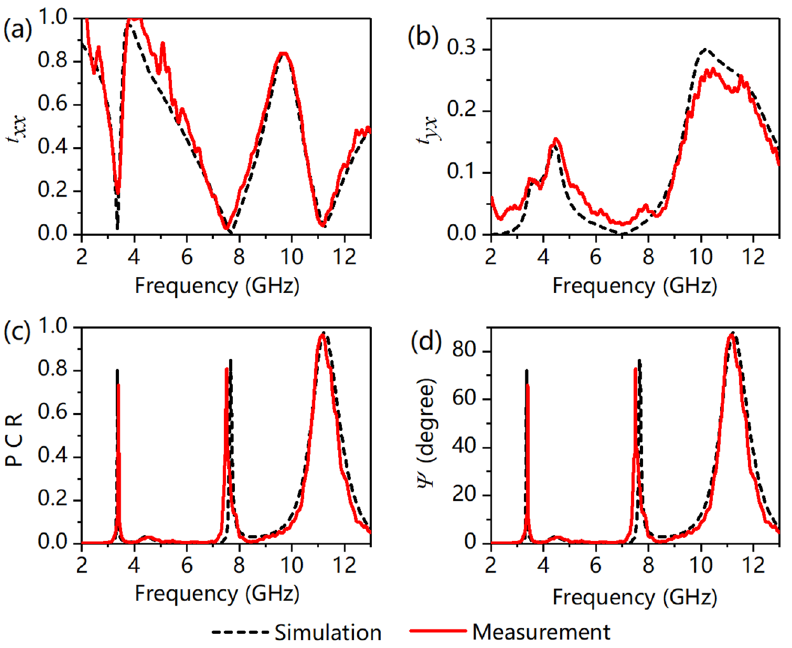
Figure 4. ( a ) Copolarization transmittance of t xx , ( b ) cross-polarization transmittance of t yx , ( c ) polarization conversion ratio (PCR), and ( d ) polarization rotation angle of Ψ